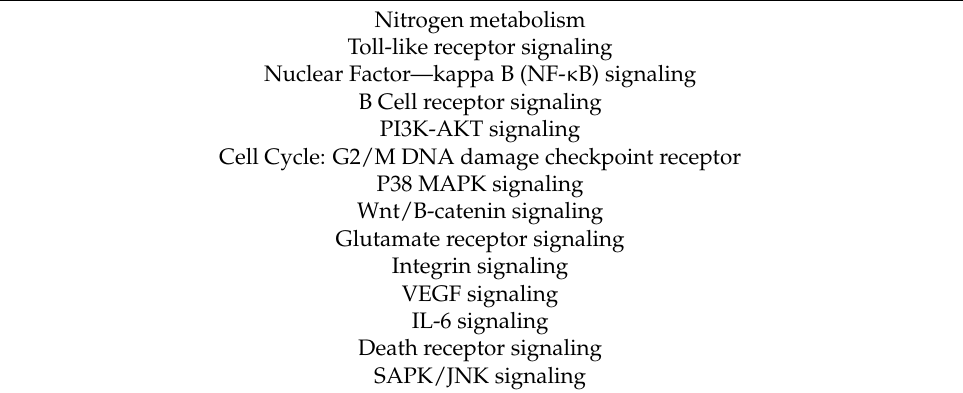
Table 5. Biological pathways involved in radiation-induced oral